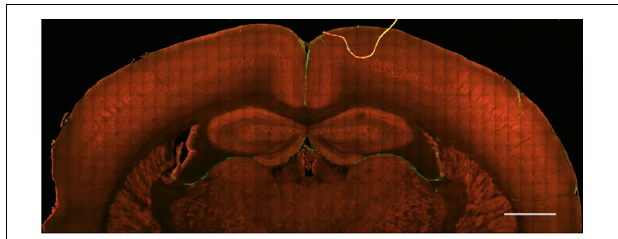
Frontiers in Neuroscience |